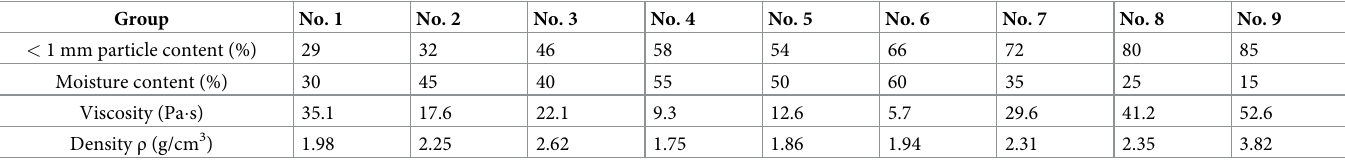
soaked and stirred with water to obtain the weathered red-bed soil slurry. The weathered red- bed soil slurry has a high viscosity, good entrainment property, and a certain plasticity and is not easy to disperse in water. According to the particle gradation of the sample, 9 of test groups are set up. The mud densities of the 9 groups of weathered red-bed soil are shown in Table 1. The mud viscosity is measured by an NDJ-8S rotary viscometer, as shown in Fig 5. The viscosity range of the weathered red-bed soil slurry used in the test is 5.7–52.6 Pa � s, the moisture content range is 15–60%, and the content of the particles with sizes smaller than 1 mm is 29–85%. The 9 types of slurries are shown in Fig 6. In this test, medium-coarse sand material with a particle size range of 0.3–0.6 mm is selected as the simulated formation material. The simulated formation material is shown in Fig 7. The simulated stratum is placed in a transparent glass container with a length, width and height of 15 mm, and a stratum with a thickness of approximately 7–8 mm is laid in the con- tainer, as shown in Fig 8. There are many weathered red-bed soils in nature. Red-bed soil has a very low acquisition cost and is environmentally friendly. It can quickly form a large number of high- quality films under natural conditions. Compared with the closed pressurization method, this method reduces the waste of resources and time and avoids the considerable environmental pollution caused by using artificial mud films. Thus, this test method has great practical significance.